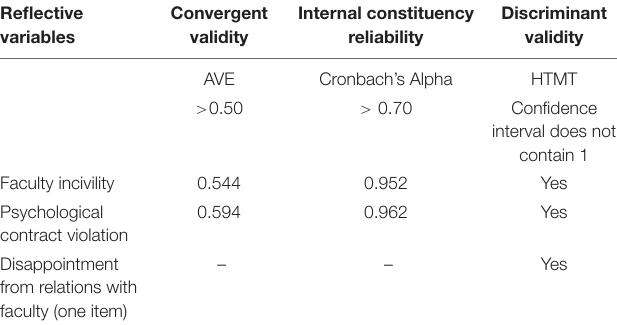
TABLE 1 | Result summary for measurement